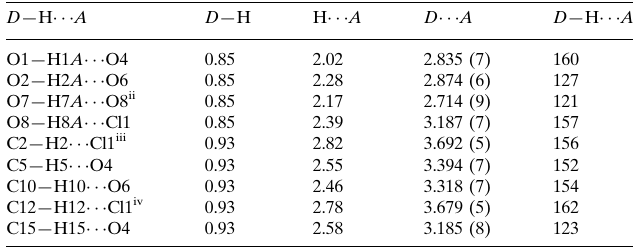
Hydrogen-bond geometry (A˚ , (cid:2)